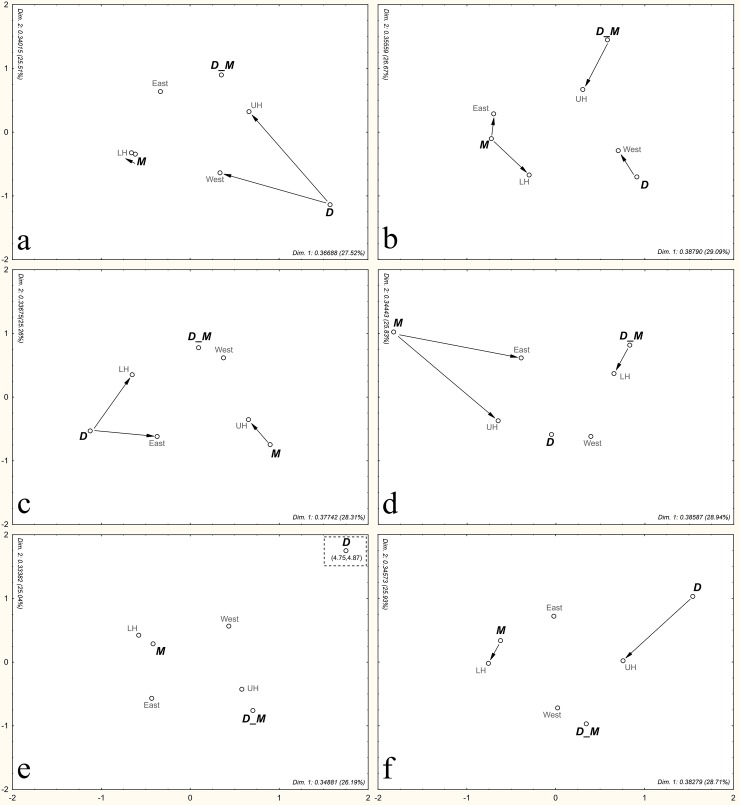
Distribution of the shoots in the canopy.Seasonal variation of the multiple correspondence analysis of relationships between the categories of side of the tree (West or East side), each strata (UH: upper half; LH: lower half), and the grouped developmental phase of new shoots (D: development, V2 and V3; D_M: development to maturation, V4 and V5; M: completely mature shoots, V6 and V7), in each assessment period (a: 1st, 2nd, and 3rd; b: 4th, 5th, and 6th; c: 7th, 8th, and 9th; d: 10th, 11th, and 12th; e: 13th, 14th, and 15th; f: 16th, 17th, and 18th). Arrows indicate significant (p < 0.05) correspondence between categories.